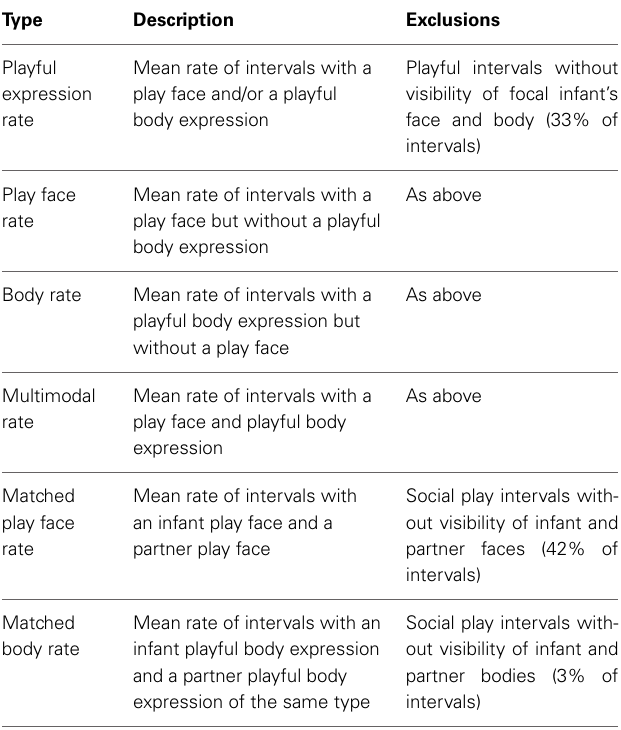
Table 3 | Description of mean rate